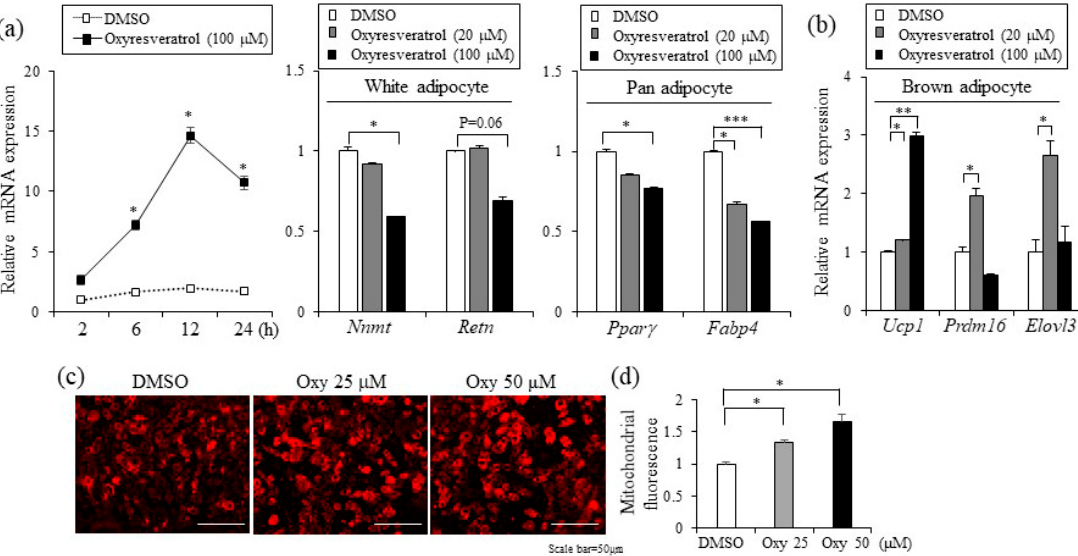
Figure 4. Oxyresveratrol induces Ucp1 and thermogenic genes in adipocytes. ( a ) C3H10T1/2 cells were differentiated into adipocytes and treated with oxyresveratrol for up to 24 h and the Ucp1 expression was measured by real-time PCR. C3H10T1/2 adipocytes were treated with oxyresveratrol for 12 h, and the expression of white adipocyte selective genes ( Nnmt and Retn ), and general adipocyte genes ( Ppar γ and Fabp4 ) were verified by real-time PCR. ( b ) T37i brown adipocytes were treated with oxyresveratrol for 24 h, and the levels of thermogenic selective markers ( Ucp1 , Prdm16 , and Elovl3 ) were measured. ( c ) Mitochondrial staining by mitochondria-specific CytoPainter (ab112145) in C3H10T1/2 adipocytes treated with dimethyl sulfoxide (DMSO) or oxyresveratrol for 24 h. ( d ) Quantification of mitochondrial fluorescence. Mitochondrial staining was quantified using National Institutes of Health (NIH) Image J software. Data represent means ± s.e.m. and are representative of three independent experiments. Statistical significance was determined relative to a control using the Student’s t -test (* p < 0.05; ** p < 0.005; *** p < 0.0005).